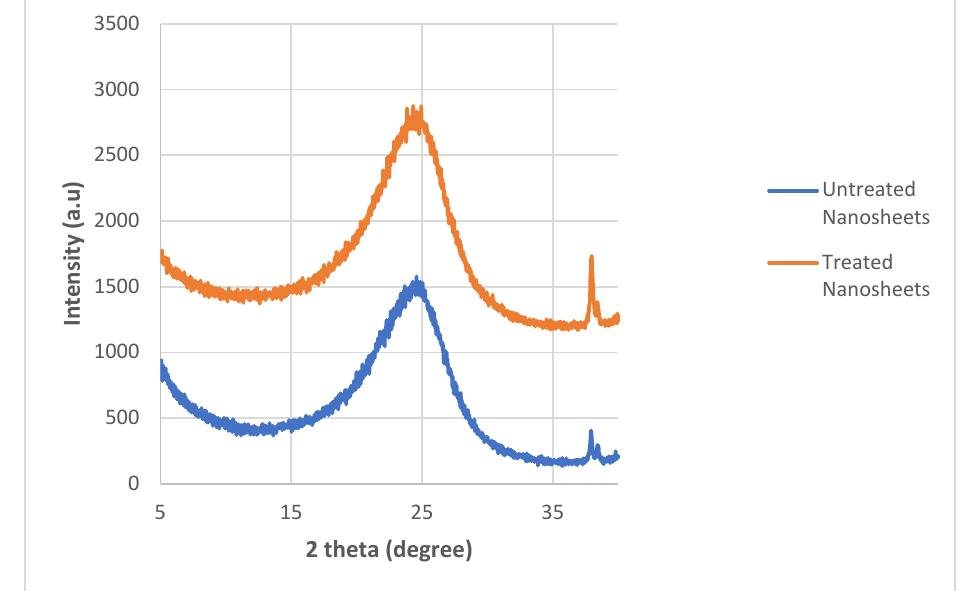
Figure 9. XRD Spectra of Treated and Untreated Graphite Nanosheets. Table 2. d -Spacing and Crystallite Size for All 2 θ = 24.6° Peaks in Treated and Untreated Nanosheets. Sample d -Spacing, Å Inter-Chain Separation ( R ), Å Treated Graphite Nanosheets